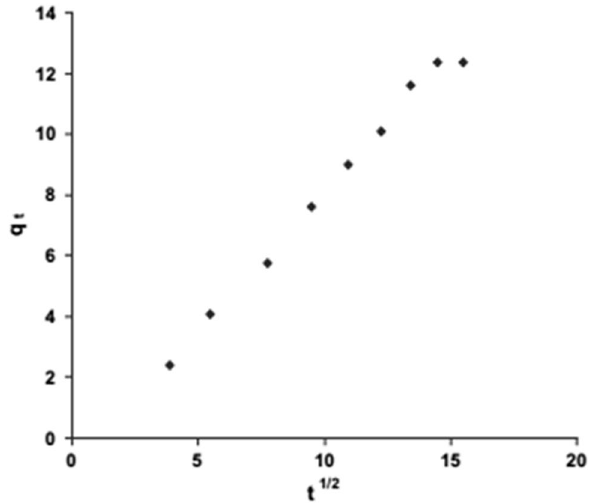
Fig. 8 Intraparticle diffusion kinetic plot for removal of MO by Anchote peel